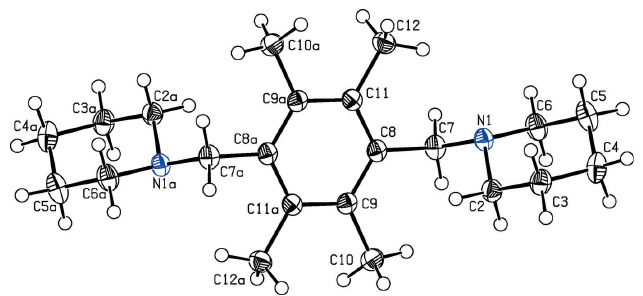
Figure 1 The molecular structure of the title compound with the atom labelling and displacement ellipsoids drawn at the 50% probability level [symmetry code: (a) 1 (cid:3) x , 1 (cid:3) y , 1 (cid:3) z ].